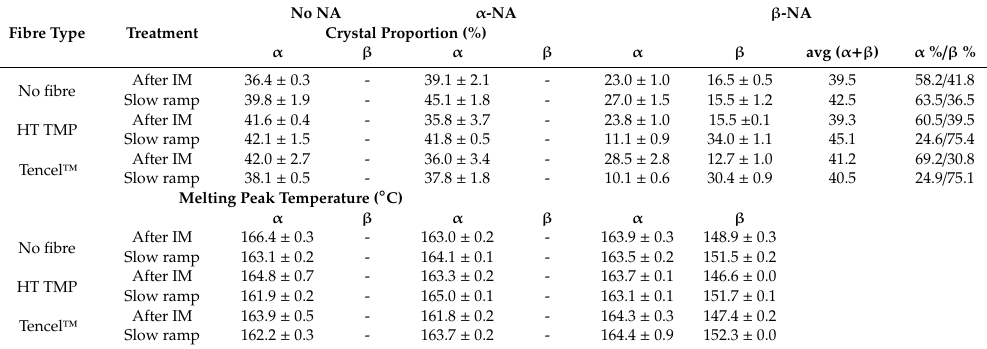
Table 1. Comparison of α and β -crystal proportions and e ff ect of α - and β -nucleating agent (NA) on iPP melting properties, after injection moulding or after melting and a slow cooling ramp (10 ◦ C / min). No NA α -NA β -NA Fibre